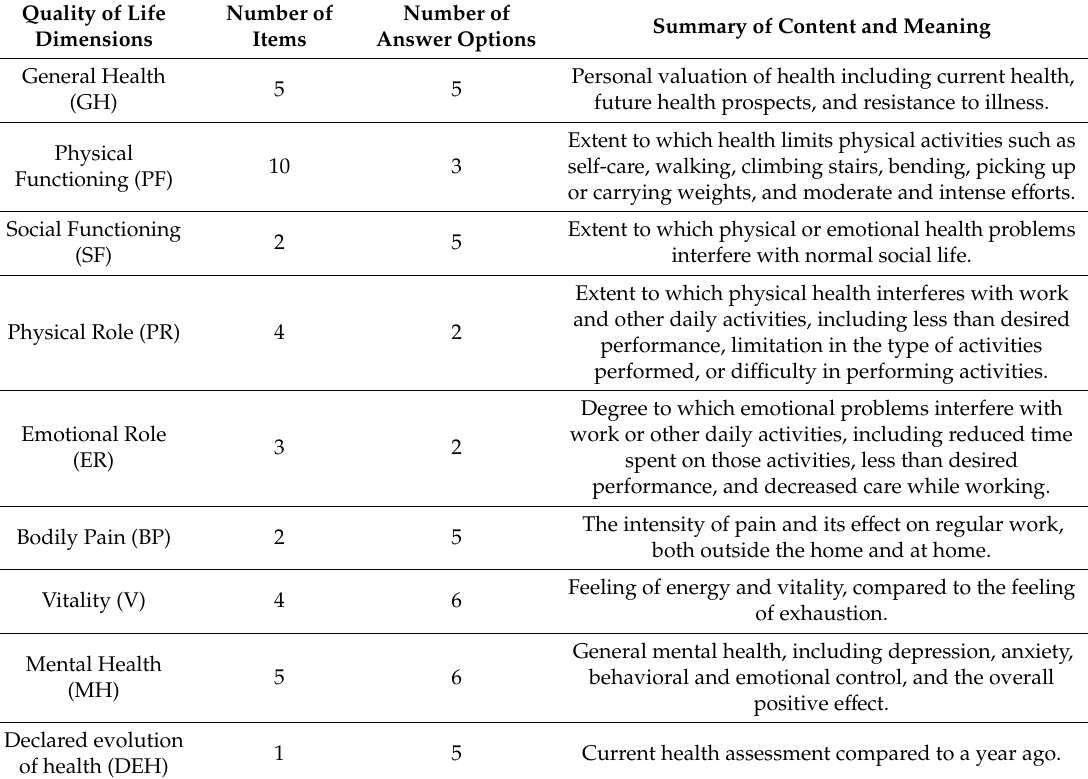
Table 1. Short-Form Health-Survey Questionnaire (SF-36): dimensions and its meaning. Quality of